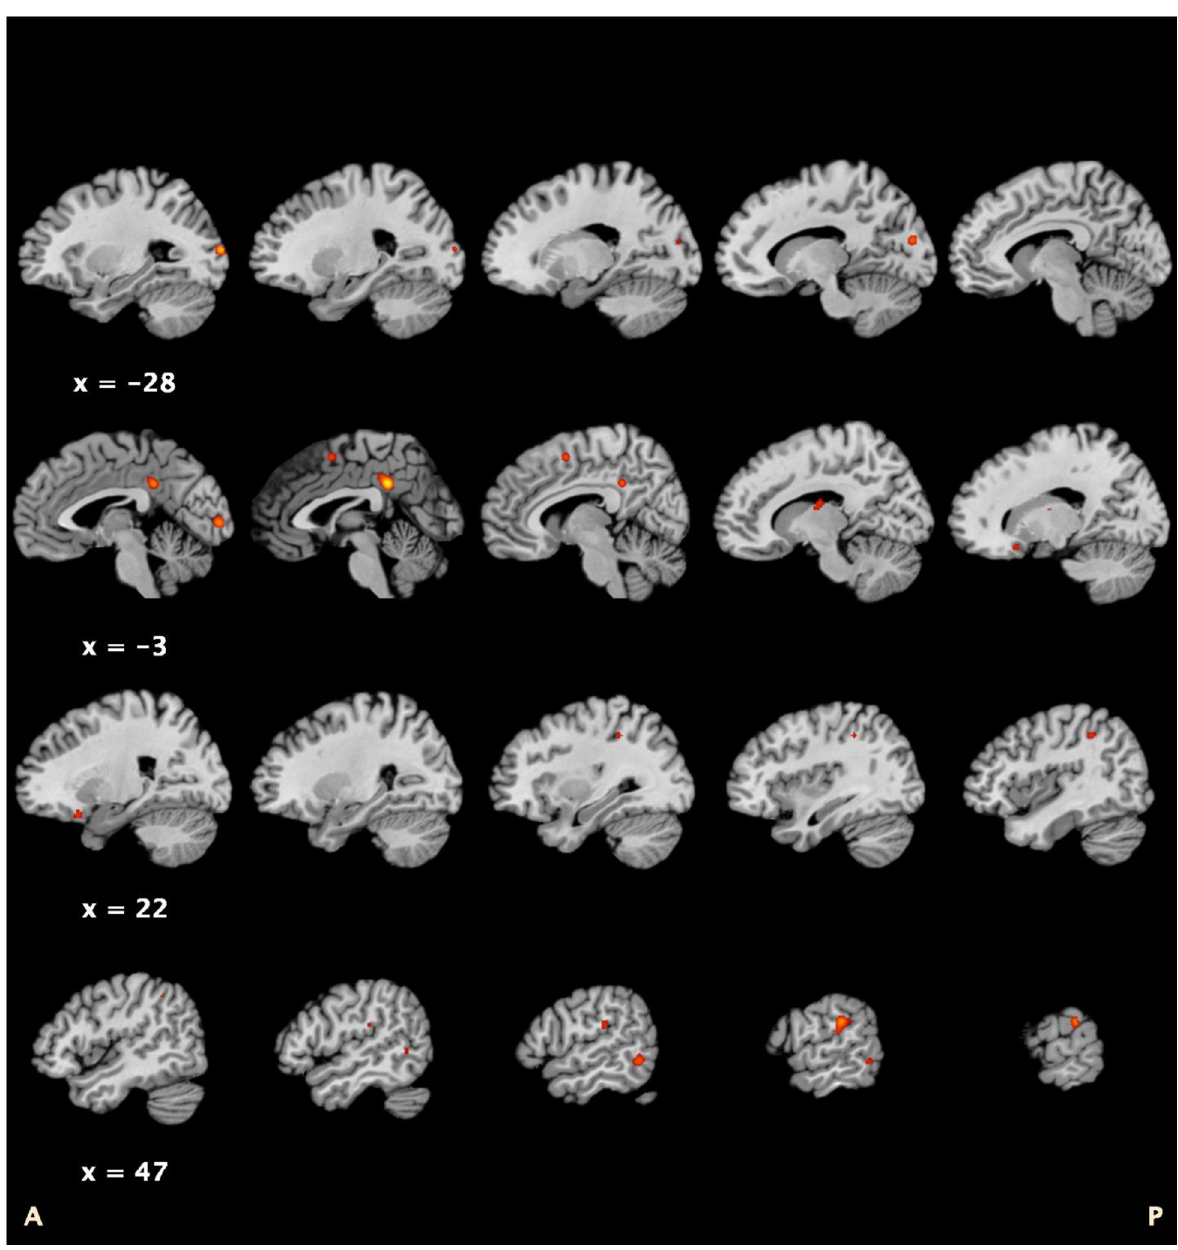
Fig 3. Regions identified by uncorrected ALE. Note: Areas in color represent the 15 regions identified by the uncorrected ALE, p < .05. https://doi.org/10.1371/journal.pone.0276140.g003 between the dorsal and ventral PCC (dPCC and vPCC, respectively) and found that the dPCC was highly co-activated with regions associated with consciousness and awareness of internal bodily sensations, hereafter called interoceptive awareness. Additionally, the vPCC was found to co-activate with regions associated with self-awareness. Related to tinnitus and the results of the current study, alteration of the PCC may hinder tinnitus patients from appropriately directing their attention away from irrelevant noise sources, and instead, increase individuals’ attention and awareness to the tinnitus percept. Therefore, therapies should aim to provide